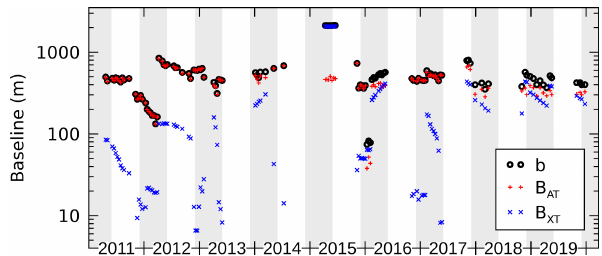
Figure 5. Time series of the bistatic baselines b according to Eq. (2) together with along- and across-track baselines B AT and B XT of the TanDEM-X satellite acquisitions of the Jungfrau–Aletsch region. Along-track baselines are adjusted by 30m due to the satellite mo- tion (see Sect. 2.2.2). Gray shading indicates the period from 1 De- cember until 31 May for which we assume that the firn, present in the accumulation area > 3500m, is completely